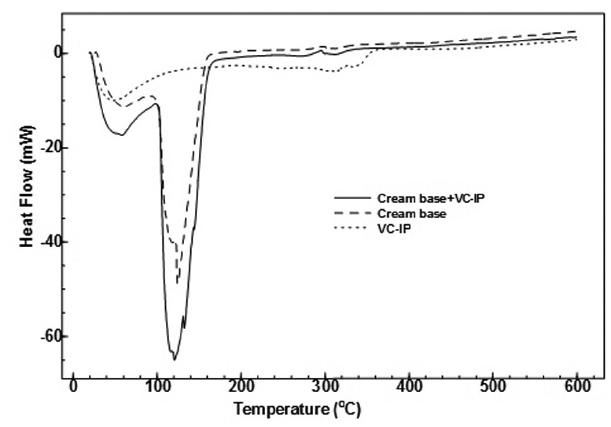
FIGURE 4 - DSC Curves of cream base, VC-IP and cream base with VC-IP samples obtained in a dynamic N2 atmosphere (50 mL min -1 ) and at a heating rate of 10 ºC min -1 .